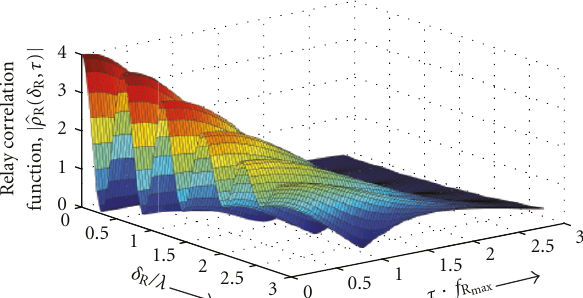
Figure 13: Absolute value of the relay CF | (cid:22) ρ R ( δ R , τ ) | of the 2 × 2 × 2 MIMO M2M stochastic channel simulator designed by applying the MMEA with K = L = 23 (nonisotropic scattering, von Mises = φ (0) = 60 ◦ and κ = κ = 40). density with φ (0) S-R R-D S-R R-D